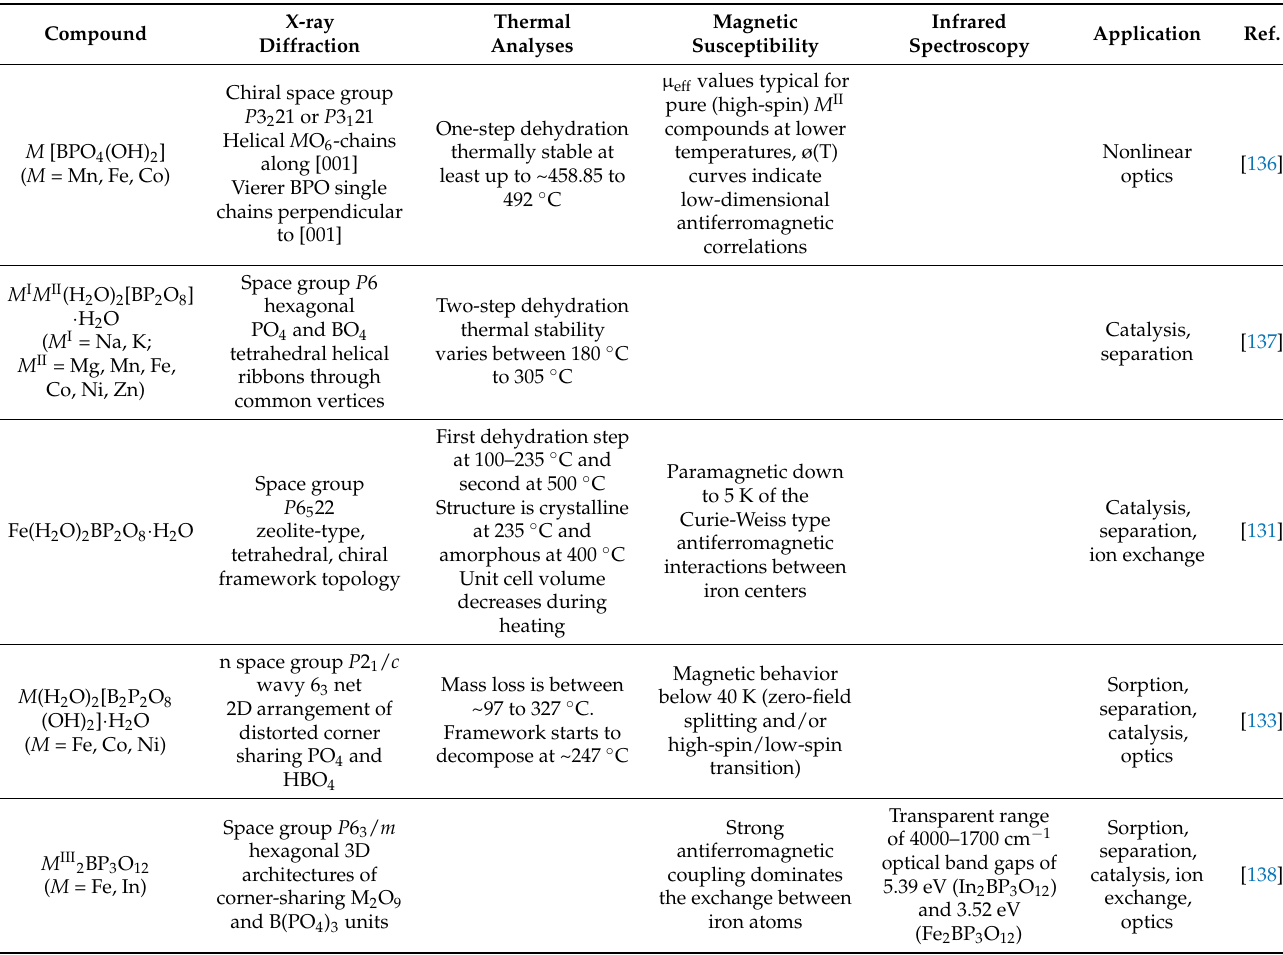
Table 7. Properties of different BPO known phases featuring earth-abundant